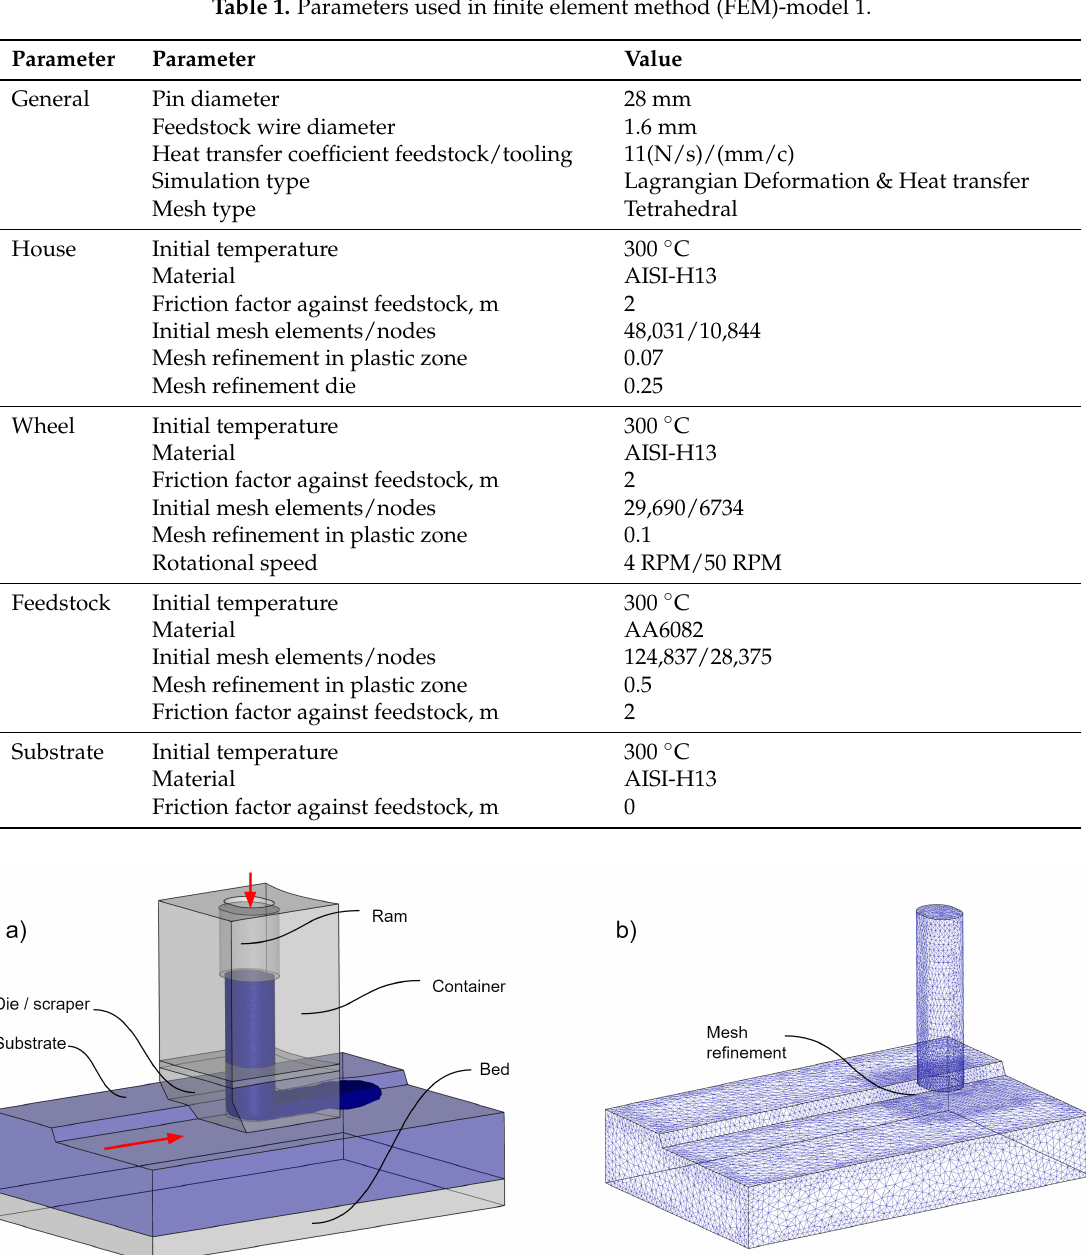
Figure 7. FEM model 2. ( a ) the material deposition is controlled by the ram speed and the horizontal movement of the substrate; ( b ) the initial mesh of the feedstock and the substrate with mesh refinement at the joining